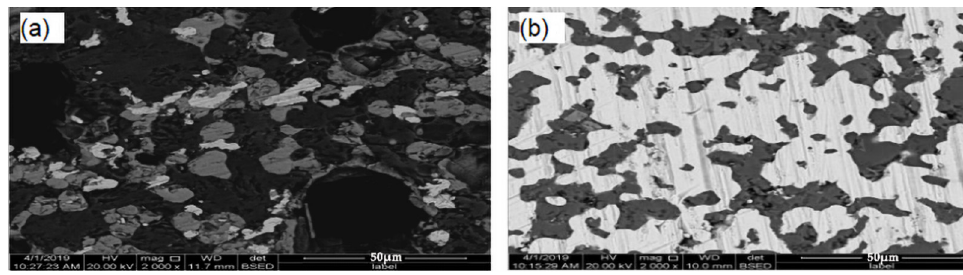
Figure 14. SEM of the cross section of DC1 and DC2; ( a ) the SEM of the DC1, ( b ) the SEM of the DC2.